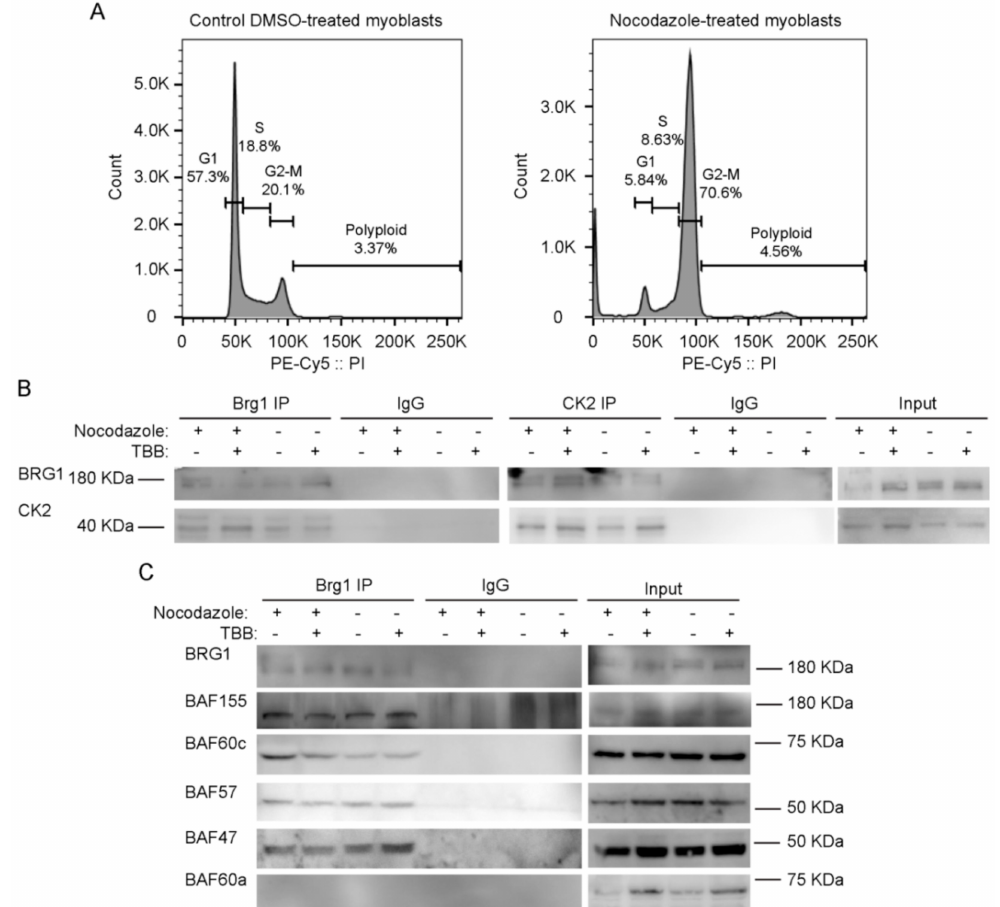
Figure 3. Inhibition of CK2 enzymatic activity does not impair its interaction with Brg1 or a ff ect the interaction of Brg1 with numerous mammalian SWItch / Sucrose Non-Fermentable (mSWI / SNF) complex proteins. Primary myoblasts were treated or not with 500 nM nocodazole and 10 µ M tetrabromobenzotriazole (TBB). ( A ) Representative fluorescence-activated cell sorting (FACS) analyses of primary myoblasts treated or not with nocodazole. ( B ) Representative Western Blots from a reciprocal immunoprecipitations of Brg1 (left panel) or CK2 (middle panel). IgG inputs (IPs) and input (1%) for both proteins are shown as controls. ( C ) Representative Western Blots of Brg1 immunoprecipitation and Western Blots for the mSWI / SNF subunits BAF155, BAF60c, BAF57, BAF47, and BAF60a. IgG and inputs (2%) for all samples were included as controls. Three independent biological replicates were